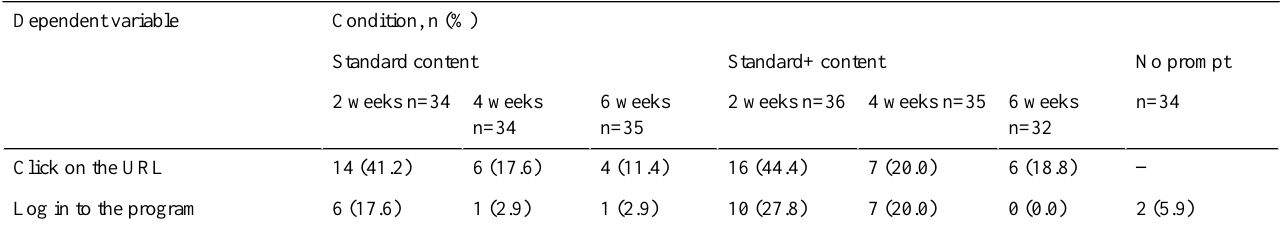
Table 1. Participants who clicked on the URL (step 1) and logged in to the program (step 2) per study condition (N=240). Condition, n (%)Dependent variable